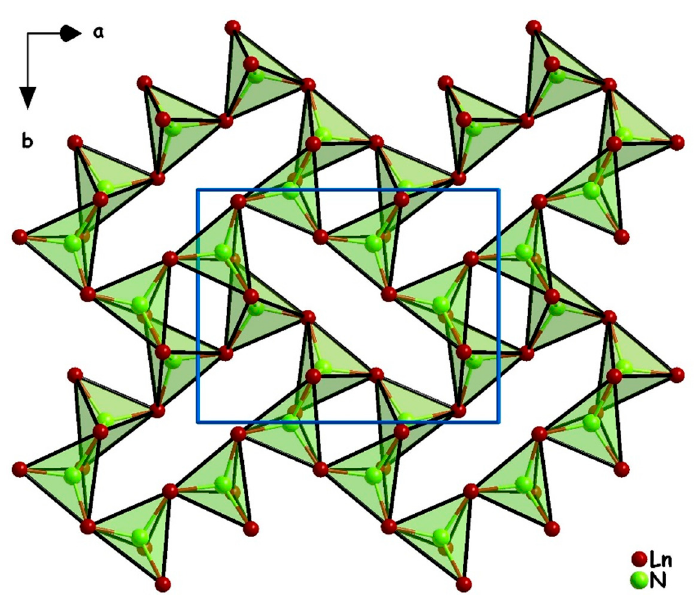
Figure 5. Linkage of tetrahedral [N Ln 4 ] 9+ units via edges to dimers [N 2 Ln 6 ] 12+ , their initial linear vertex connection to quadruples [N 4 Ln 10 ] 18+ and their final vertex fusion to porous sheets 2 ∞ {[N Ln 4/2 ] 3+ } perpendicular to [001] consisting of four- and eight-membered rings in the crystal structure of the B-type Ln 4 N 2 S 3 series ( Ln = La, Pr).